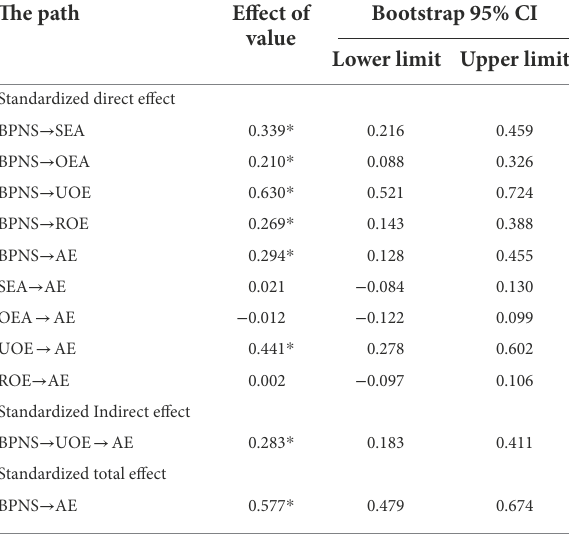
TABLE 5 Test of multiply mediation